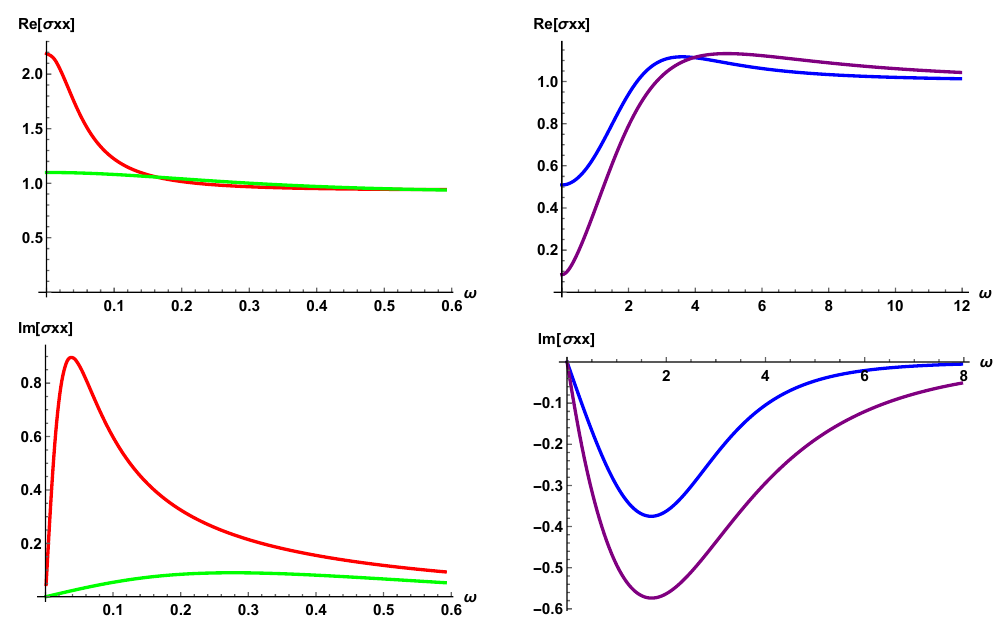
Figure 10 . Representative examples of the AC electric conductivity (cid:27) xx for the Linear model (3.23) with unitary charge density (cid:26) = 1. There are four phases: (a) good metal (red) with ( (cid:11) = 0 : 6 ; T = 0 : 5), (b) incoherent metal (green) with ( (cid:11) = 1 : 5 ; T = 0 : 5), (c) bad insulator (blue) with ( (cid:11) = 4 : 5 ; T = 0 : 3) and (d) good insulator (purple) with ( (cid:11) = 7 : 8 ; T = 0 : 05). As the strength of disorder e(cid:11)ect becomes strong, the Drude peak of the good metal becomes broader and disappears, and there is a transition to incoherent metal (green). For su(cid:14)ciently strong disorder e(cid:11)ect, a growing peak in the mid-infrared develops (blue and purple), and the system becomes an